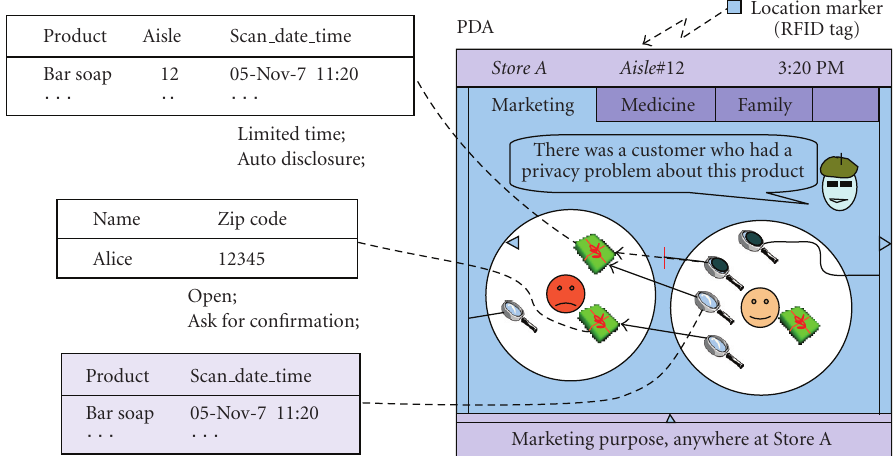
Figure 5: A user interface